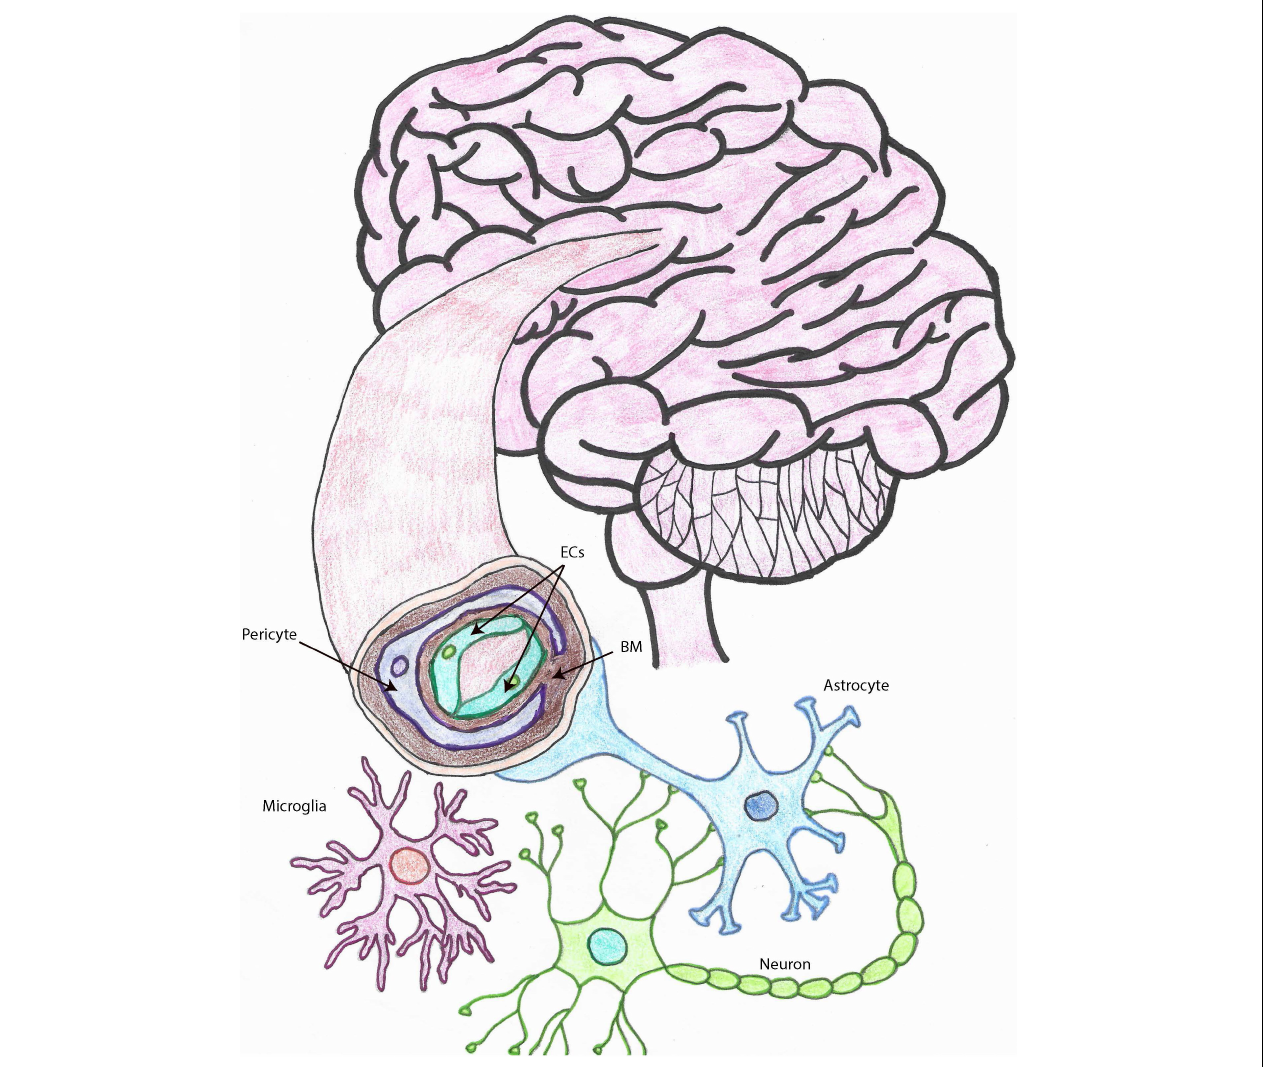
FIGURE 1 | The neurovascular unit. Drawing depicting the cell types that make up the NVU within brain capillaries. Brain capillaries are surrounded by pericytes, as shown in this figure, while arteries and arterioles are surrounded by SMCs. Other important cells associated with blood vessels and important for BBB and neurovascular functions, also represented in this drawing, are astrocytes and microglia. ECs, endothelial cells; SMCs, smooth muscle cells; BBB, blood brain barrier; NVU, neurovascular unit; MCs, microglia cells, BM, basement